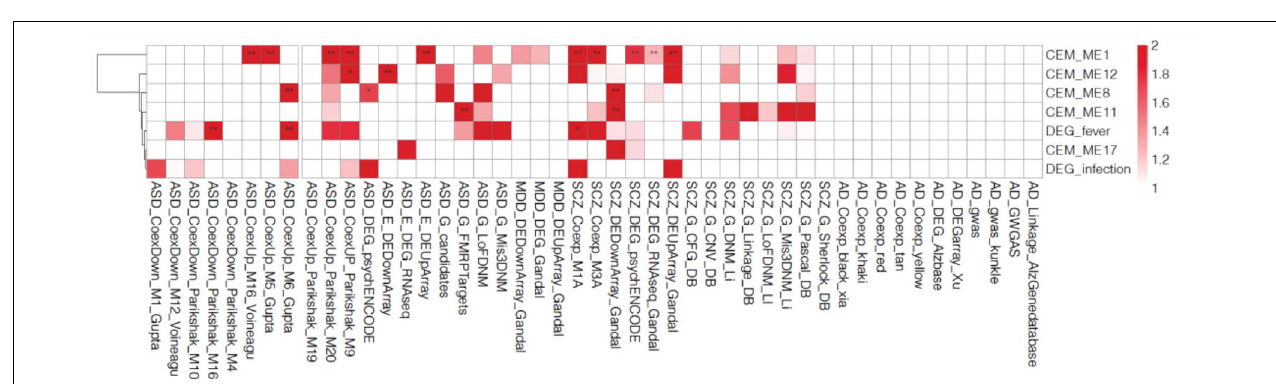
FIGURE 5 | Cell-type specificity enrichment. We identified agonal-related modules enriched within neurons, microglia, and endothelial cells.